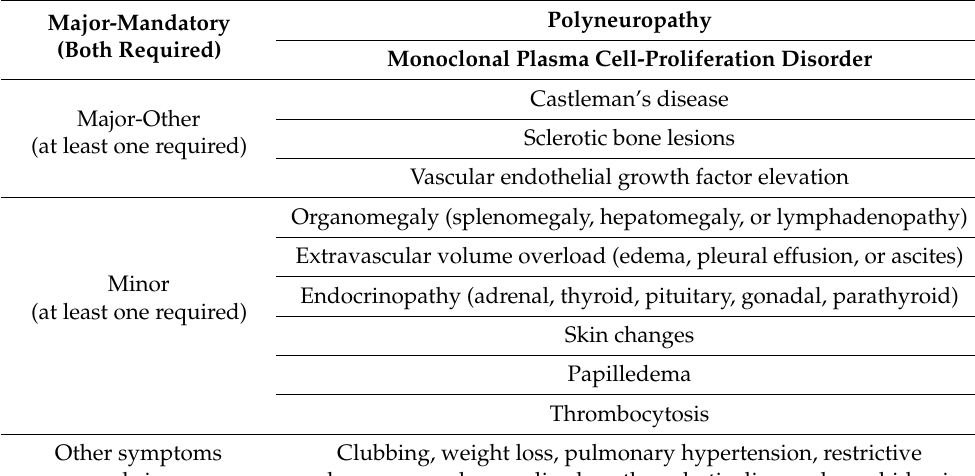
Table 6. POEMS syndrome diagnostic